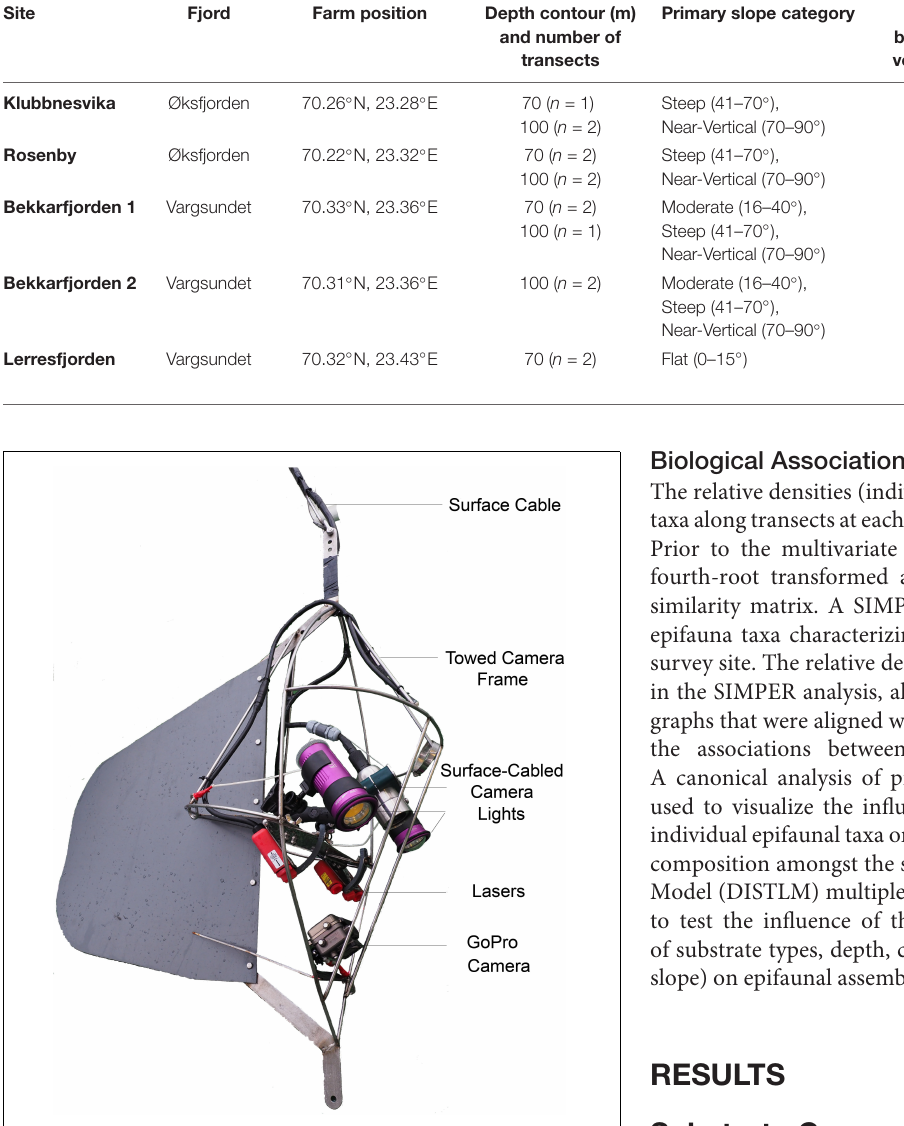
FIGURE 2 | Annotated diagram of the towed underwater camera system used to record substrate coverage and associated epifauna